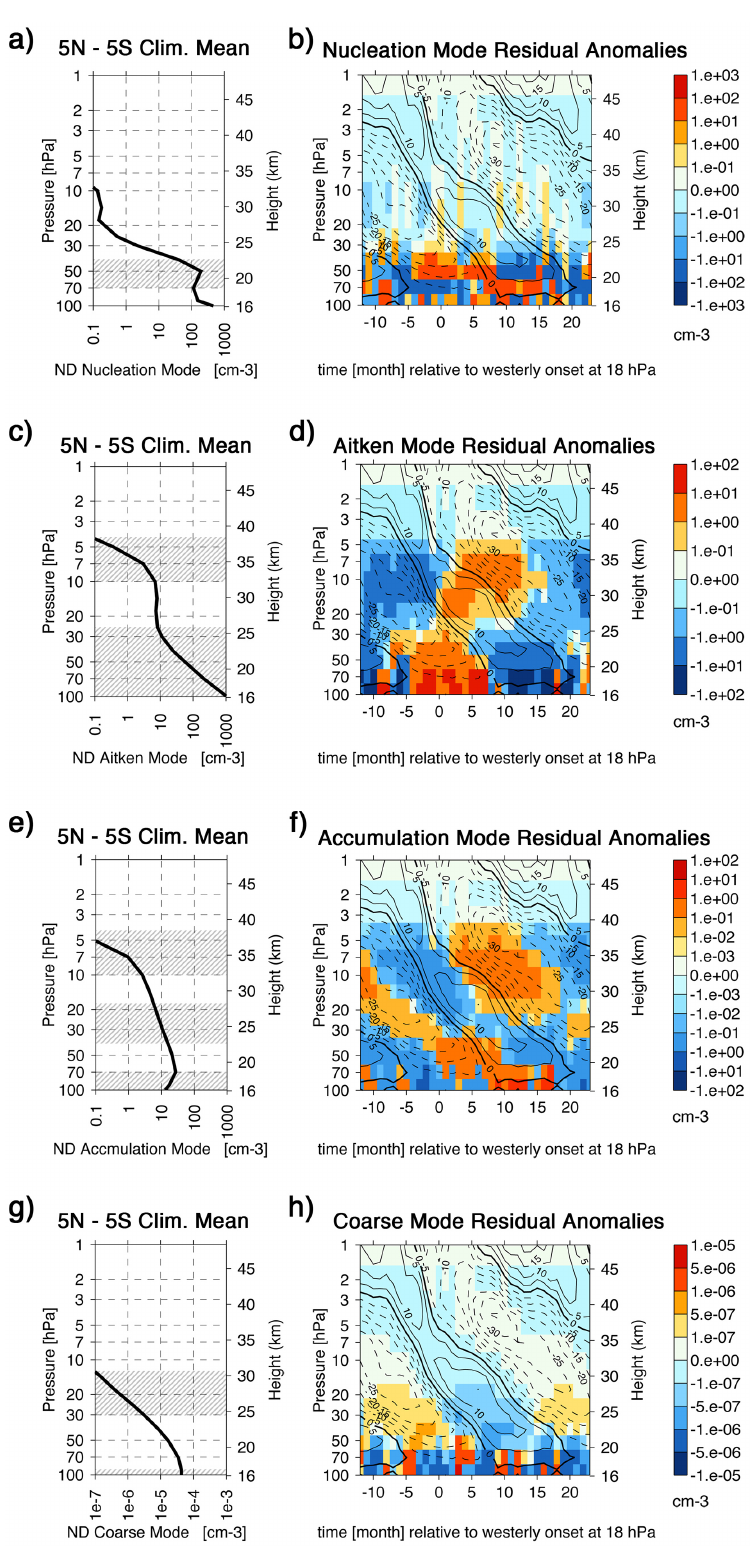
Figure 10. As in Fig. 6, except for modelled number densities as integrals over specified modes: (a) and (b) nucleation mode ( R < 0 . 005µm), (c) and (d) Aitken mode (0 . 005 µm ≤ R < 0 . 05 µm), (e) and (f) accumulation mode (0 . 05 µm ≤ R < 0 . 5 µm), and (g) and (h) coarse mode ( R ≥ 0 . 5